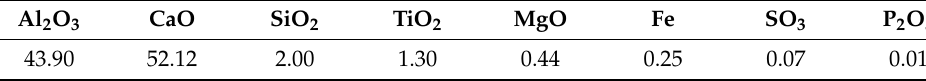
Table 1. XRF analysis of the calcium aluminate slag.